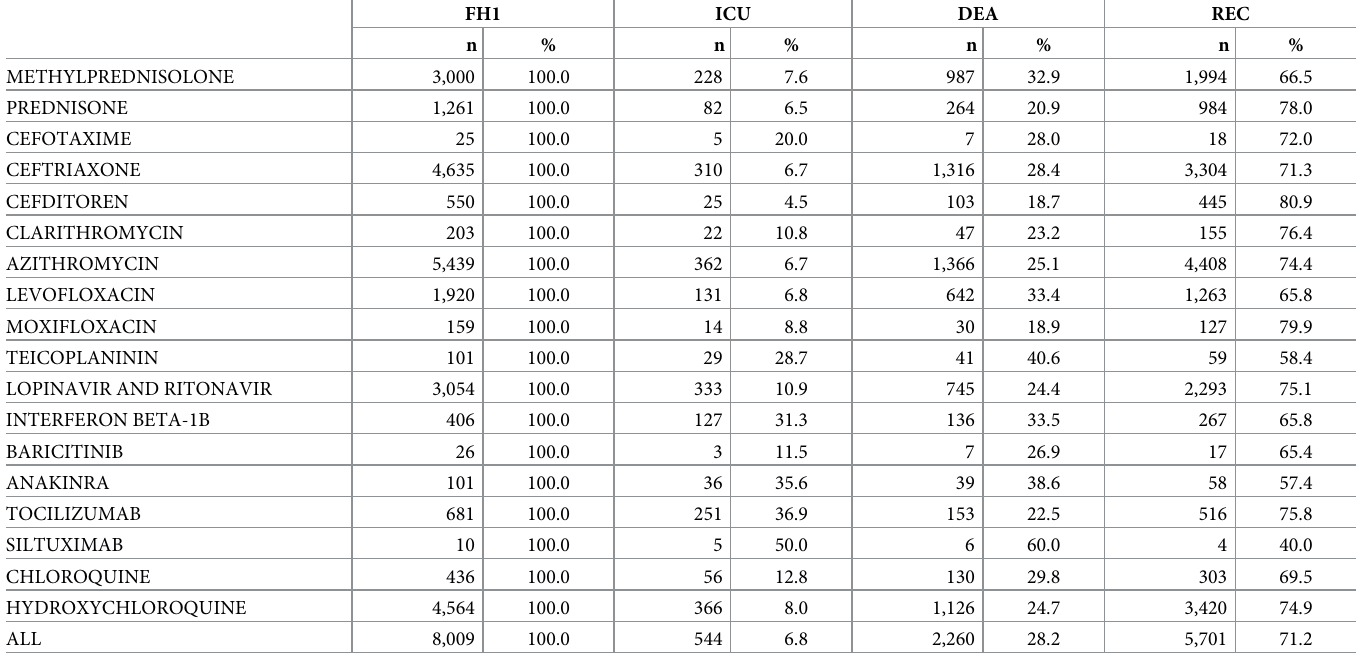
Table 3. Distribution of patients by drug therapies and states.